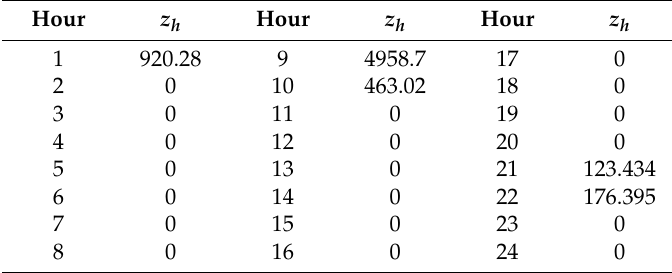
Table 3. Running results of GA-based method.